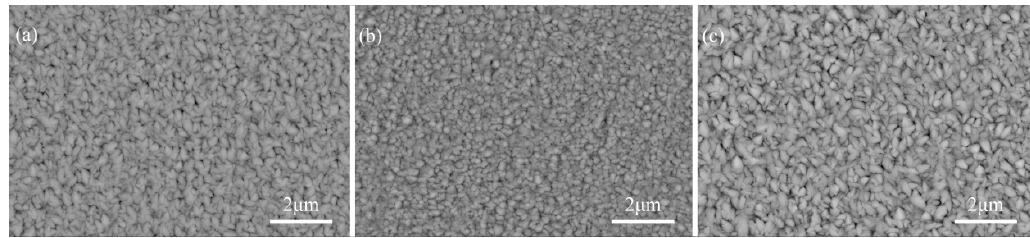
Figure 4. Surface morphologies of the CrN x coating under different filament currents: ( a ) 3 A, ( b ) 4 A, ( c ) 5 A.